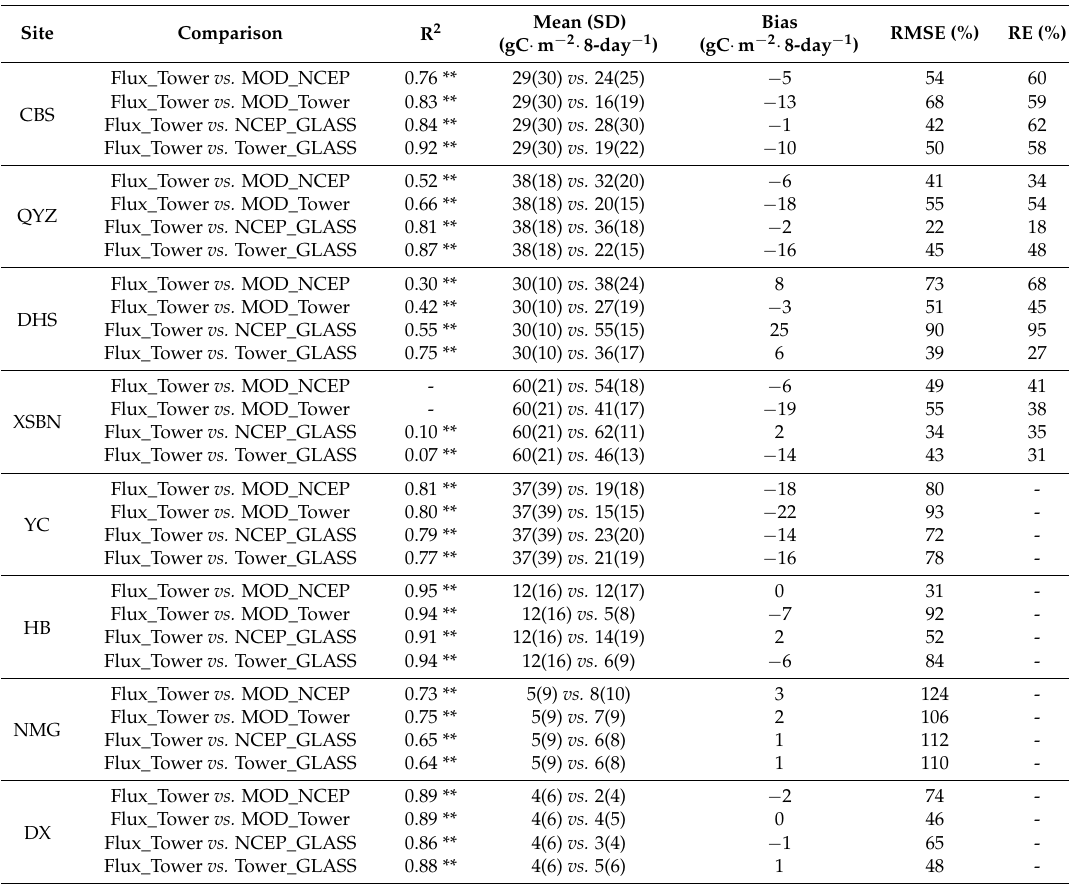
Table 2. Comparison of eight-day GPP derived from the tower estimates with those derived from the MODIS algorithms (MOD_NCEP GPP, MOD_Tower GPP, NCEP_GLASS GPP, and Tower_GLASS GPP) at eight sites. The full name for each site is listed in Table